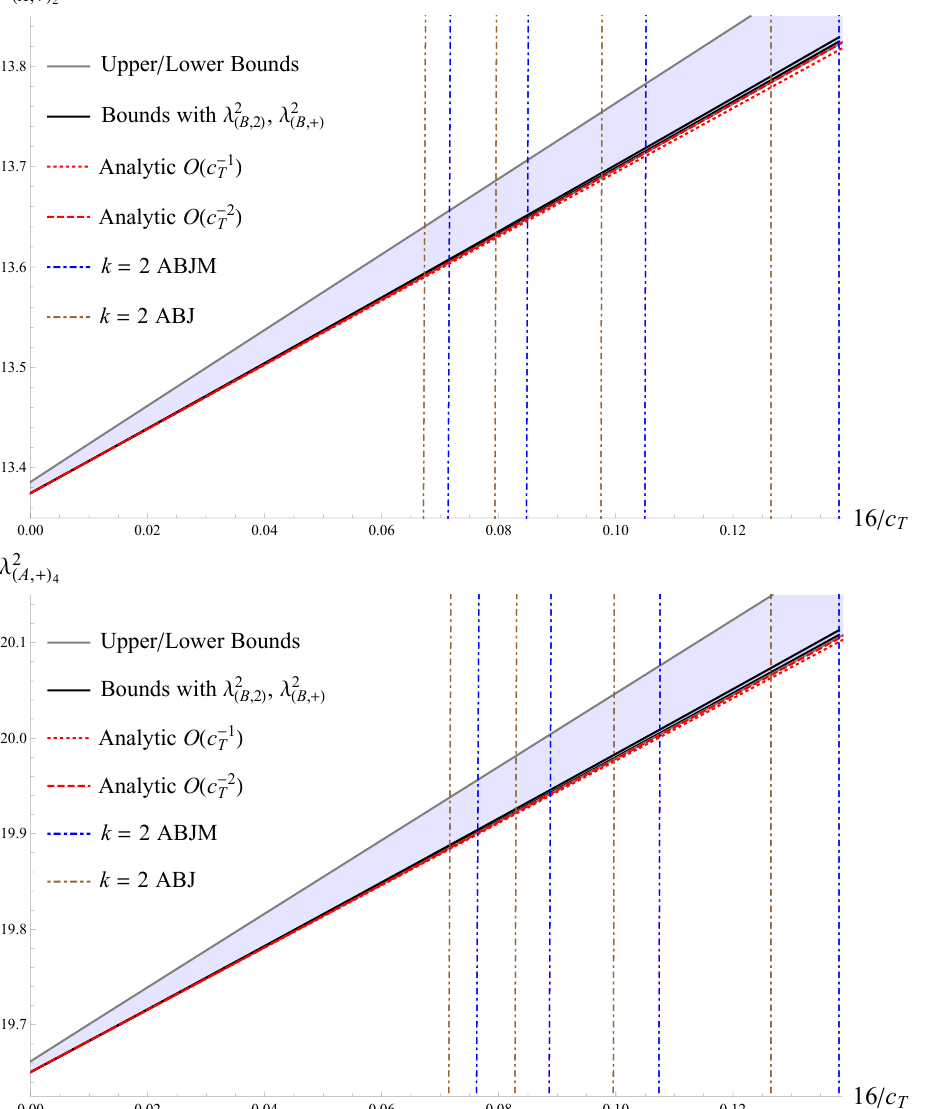
OPE coefficient for ‘ = 2 (top) and ‘ = 4 ( A, +) ‘ and λ 2 for k = 2 ABJ(M) inputed into the ( B, +) ( B, 2) ) , which is independent of k . The red dashed T ) , which depends on the value k = 2 , T ) . The blue and brown vertical T